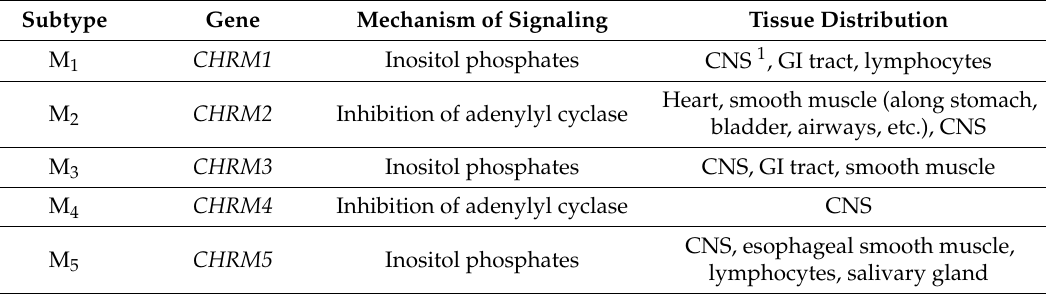
Table 1. Muscarinic acetylcholine receptor subtypes. Primary signaling mechanisms and examples of tissue types expressing muscarinic receptor subtypes are